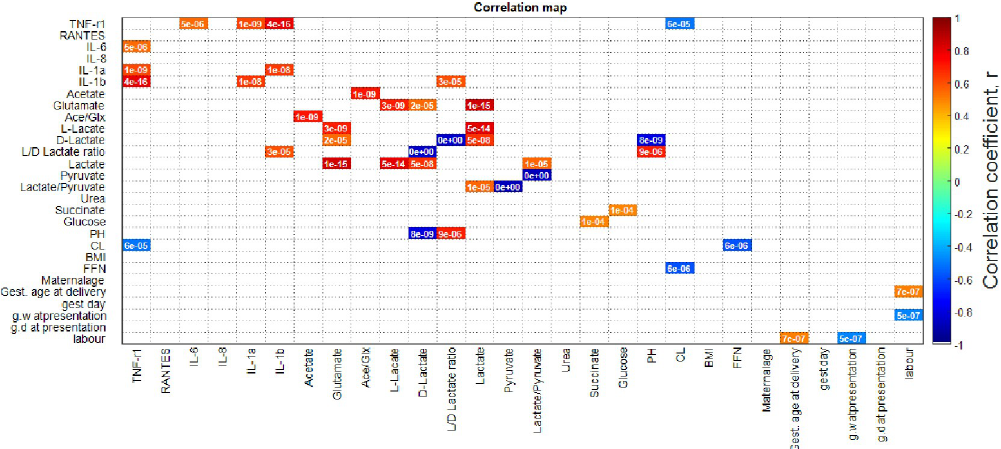
Fig 3. Correlation of cervicovaginal fluid pro-inflammatory mediators, metabolite concentrations and maternal clinical and demographic details. Spearman’s correlation coefficients ( r , colour) range from -1 (dark blue) to +1 (dark red); and significant P -values ( < 0.05) stated in the coloured boxes. Due to the high number (28) of compared measures, a Bonferroni corrected value of 0.05/364 = p < 0.000137 was applied to minimise Type 1 error. Ace/Glx , acetate/glutamate ratio; CL , cervical length; BMI , body mass Index; FFN , quantitative fetal fibronectin; Gest ., gestational; g . w , gestational week; g . d , gestational day; labour , latency i.e. interval between presentation and